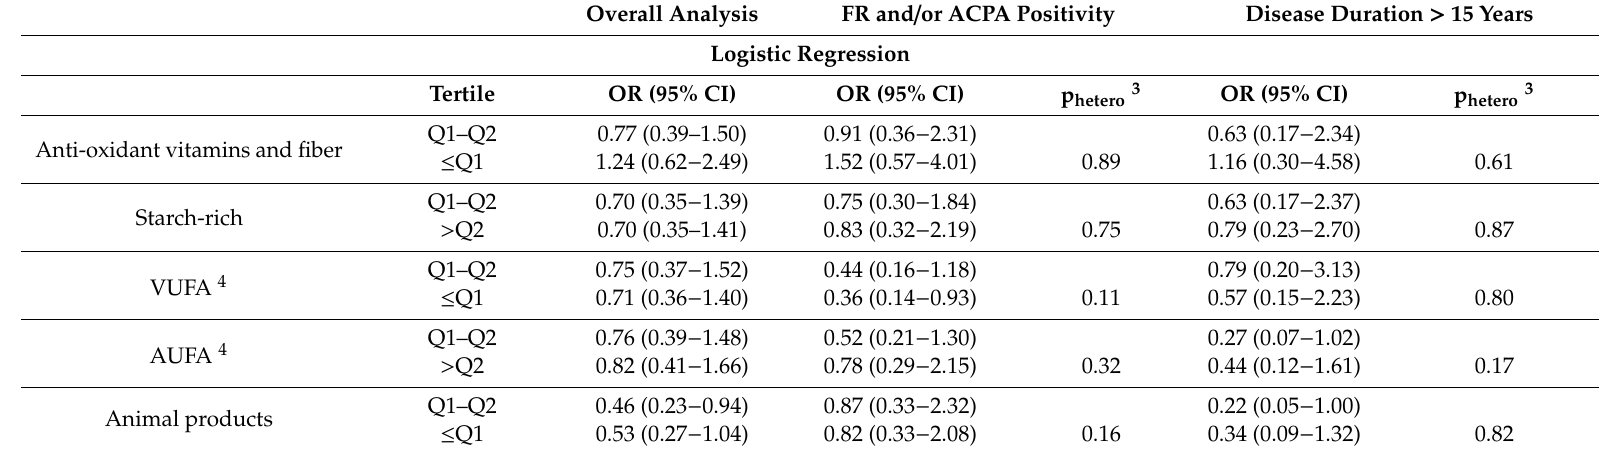
Table 4. Odds Ratios (ORs) of rheumatoid arthritis disease activity and corresponding 95% confidence Intervals (CIs) (upper panel) and increments in the mean SDAI in continuous (lower panel), according to the highest tertile-based categories of consumption of five retained dietary patterns from a principal component factor analysis 1,2